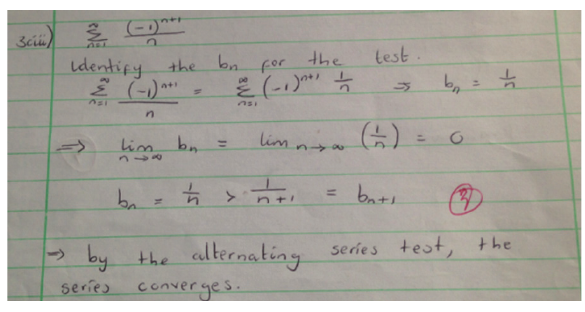
FIG URE 11: Written response of ST1 to task 1c